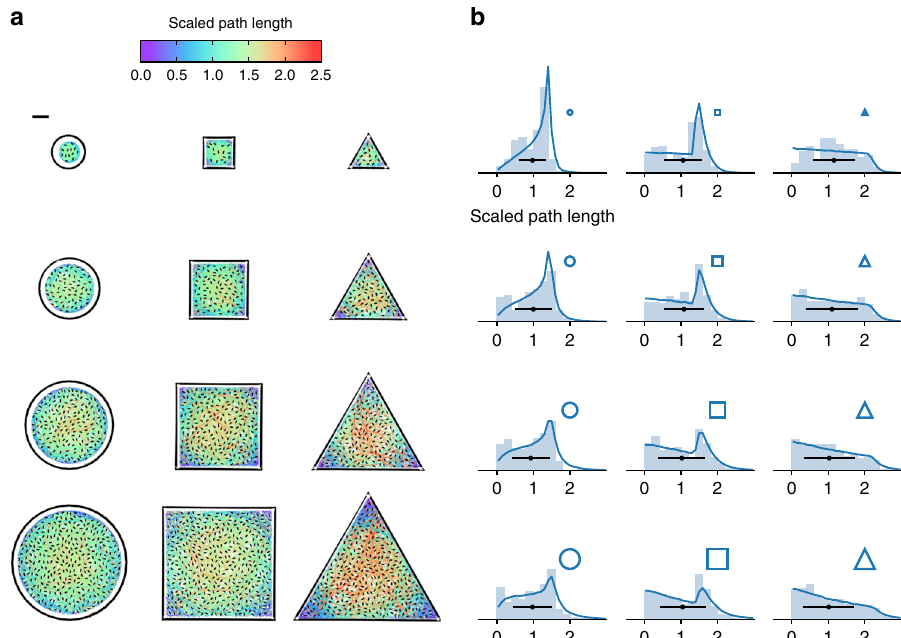
Fig. 2 Size and shape effects on path length distributions. a We fabricate microstructures with circular, squared and triangular shapes all in four different sizes varying by an overall factor of 4 (the scalebar is 20 μ m). The density of obstacles is the same for all structures. Bacterial trajectories are plotted over microstructure images that have been processed for contrast enhancement. Trajectories are color coded according to their scaled length (see colorbar). b Bar plots are the experimental distributions of scaled path lengths for each of the structures in a . The black points represent the mean scaled path length and the errorbar the corresponding standard deviation. Lines are theoretical distributions obtained by the numerical simulation of a Lorentz gas model